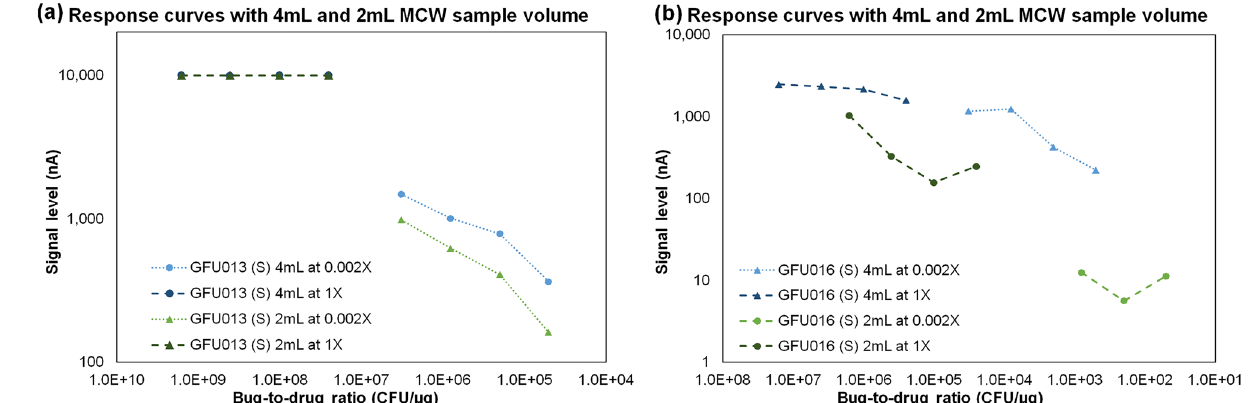
Figure 2. Representative results of MCW direct-from-specimen AST with different specimen volume. Conditions include 100% HRP, 3-h antibiotic exposure time, 1×/0.002× specimen dilution concentrations, comparison of 4-mL and 2-mL starting volumes. ( a ) Susceptible high microbial load specimen with starting volume of 4 mL and 2 mL, ( b ) susceptible low microbial load specimen with starting volume of 4 mL and 2 mL. Each error bar represents 2 data